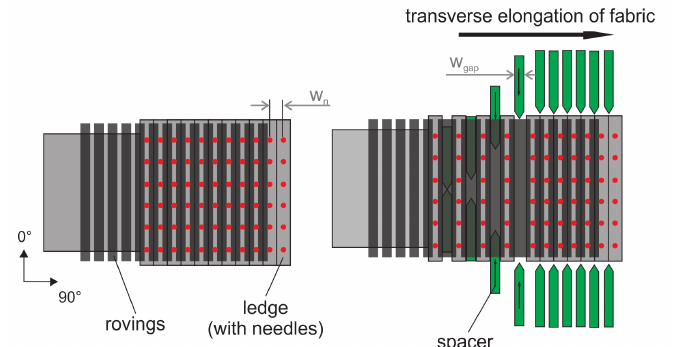
Figure 2. Sliding mechanism with needle ledges to induce gaps between the roving bundles (black—roving, grey—ledge with needles (red), dark grey—spacer ). ( Left ): undeformed state; ( Right ): spacers are inserted between the needle